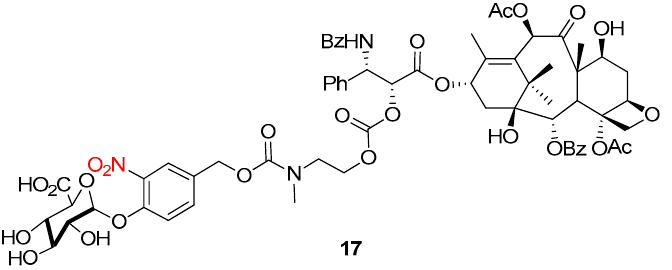
Figure 2. Paclitaxel prodrugs containing a carbonate moiety on the linker.